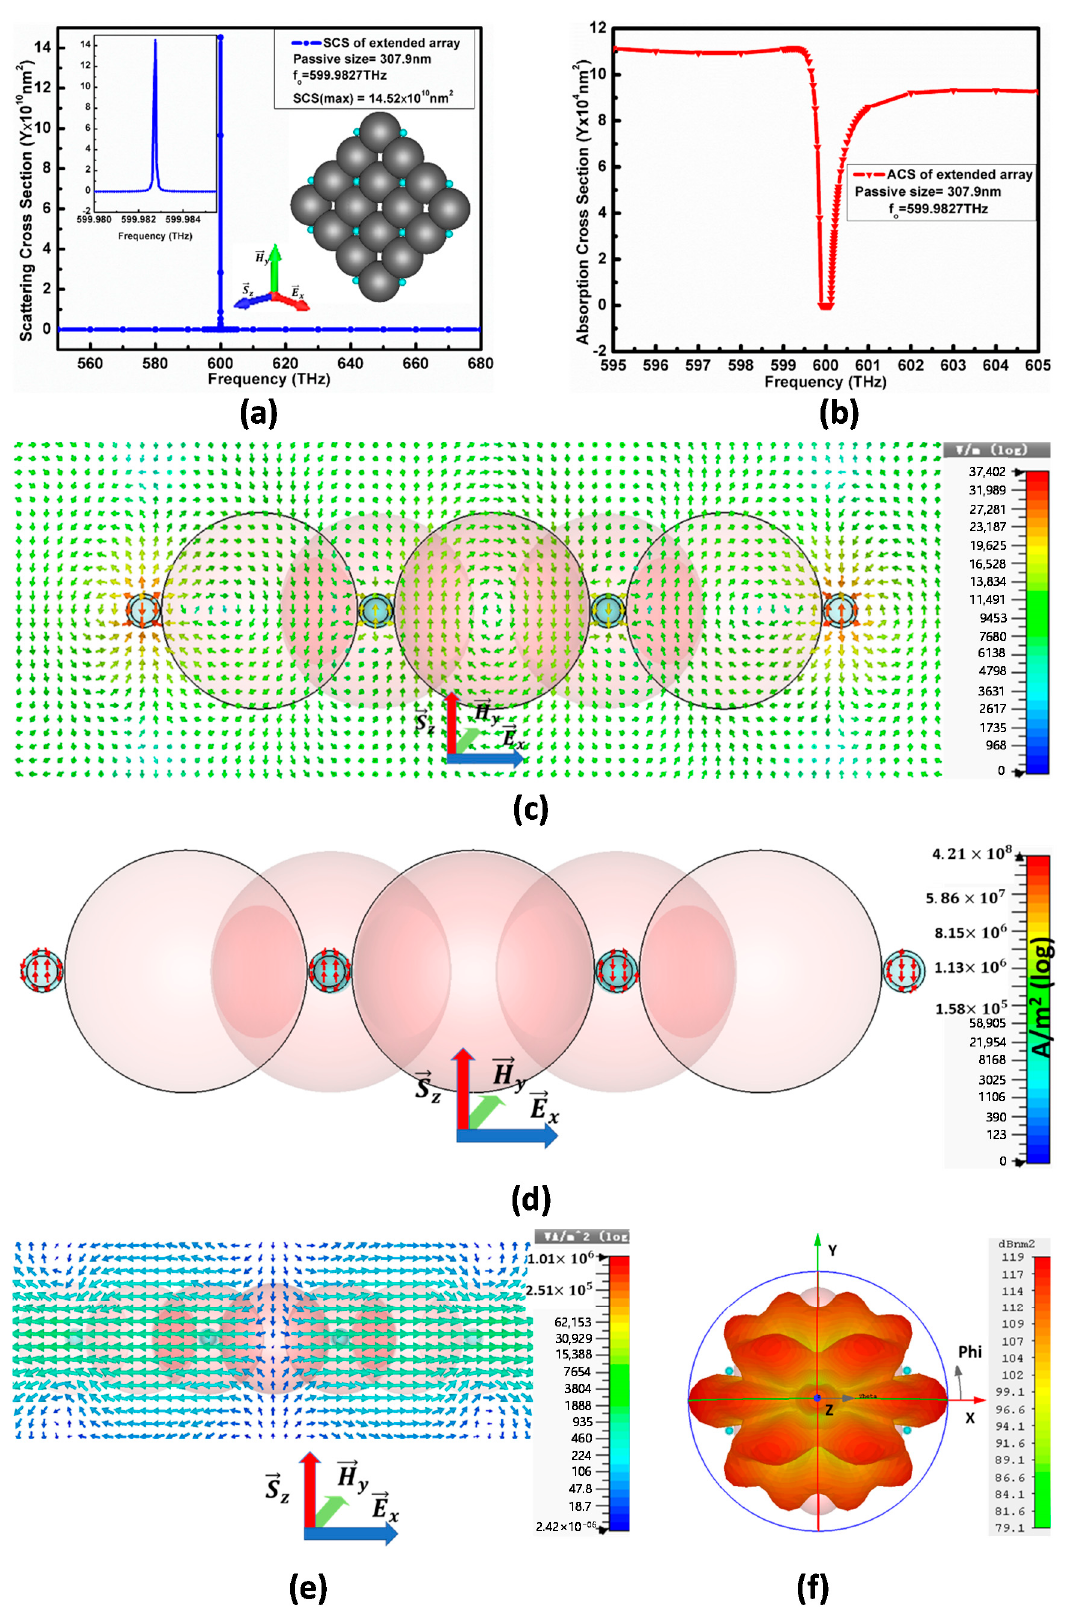
Figure 11. ( a ) denotes SCS peak for extended array model and ( b ) represents its ACS at resonance Figure 11. ( c ) denotes electric field pattern from top view while ( d ) shows its current density. Similarly, ( e ) gives power flow spectrum and ( f ) far-field pattern of extended array model at resonance state.